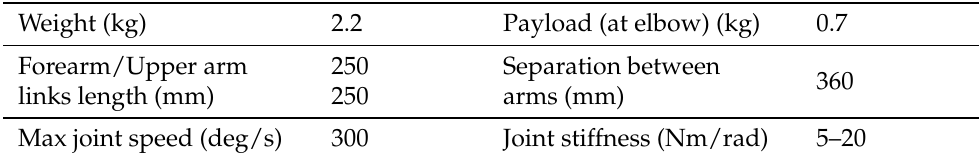
Figure 6. Kinematic model of the LiCAS A1 representing the joint angles and link lengths ( left ) and manipulation of helical bird diverter with LiCAS A1 anthropomorphic dual arm ( right ). Table 2. Main mechanical features of the LiCAS A1 dual-arm